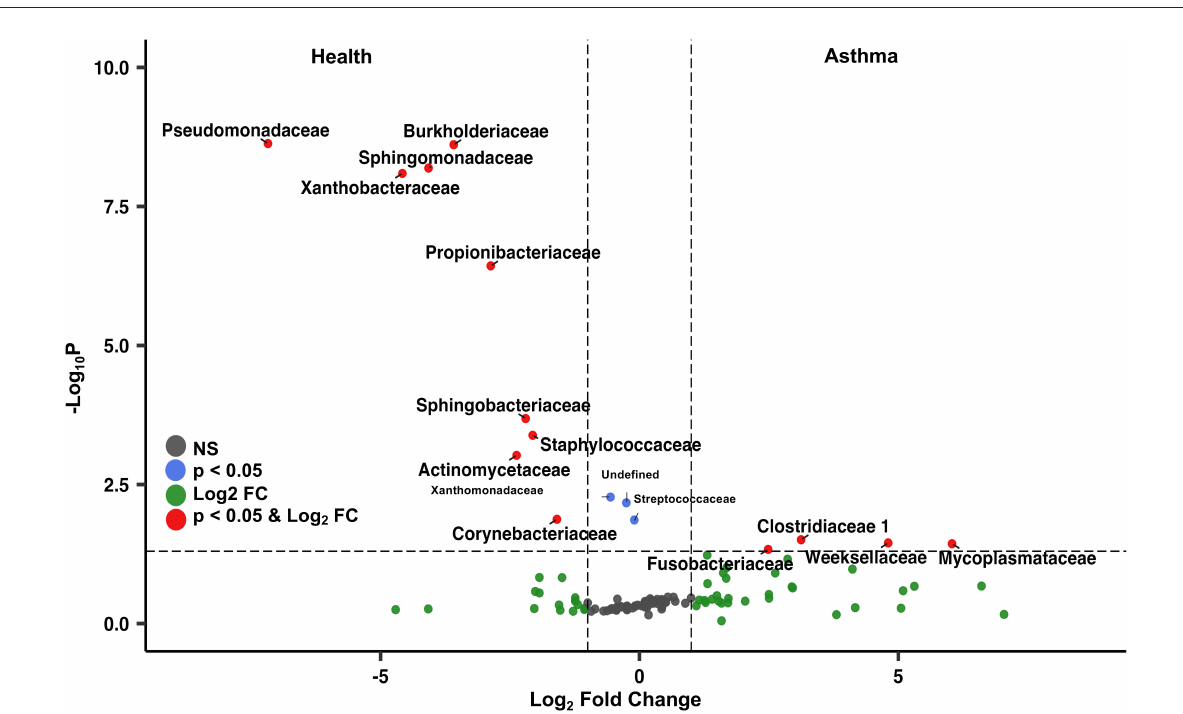
FIGURE4 Volcano plot highlighting the most abundant families in the lower airways that were significantly different ( p < 0.05) and underwent at least a 2-fold change in abundance in asthmatic pet cats compared to healthy cats. The taxa on the top left were more abundant in health, whereas the taxa on the right were more abundant in asthmatic pet